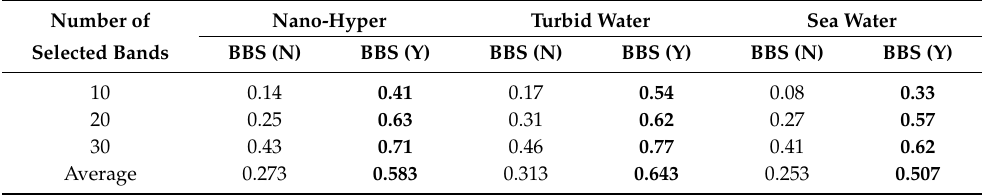
Table 4. The values of statistical magnitude σ for confirming the effectiveness of SRRBSS. Number of Nano-Hyper Turbid Water Sea Water Selected Bands BBS (N)